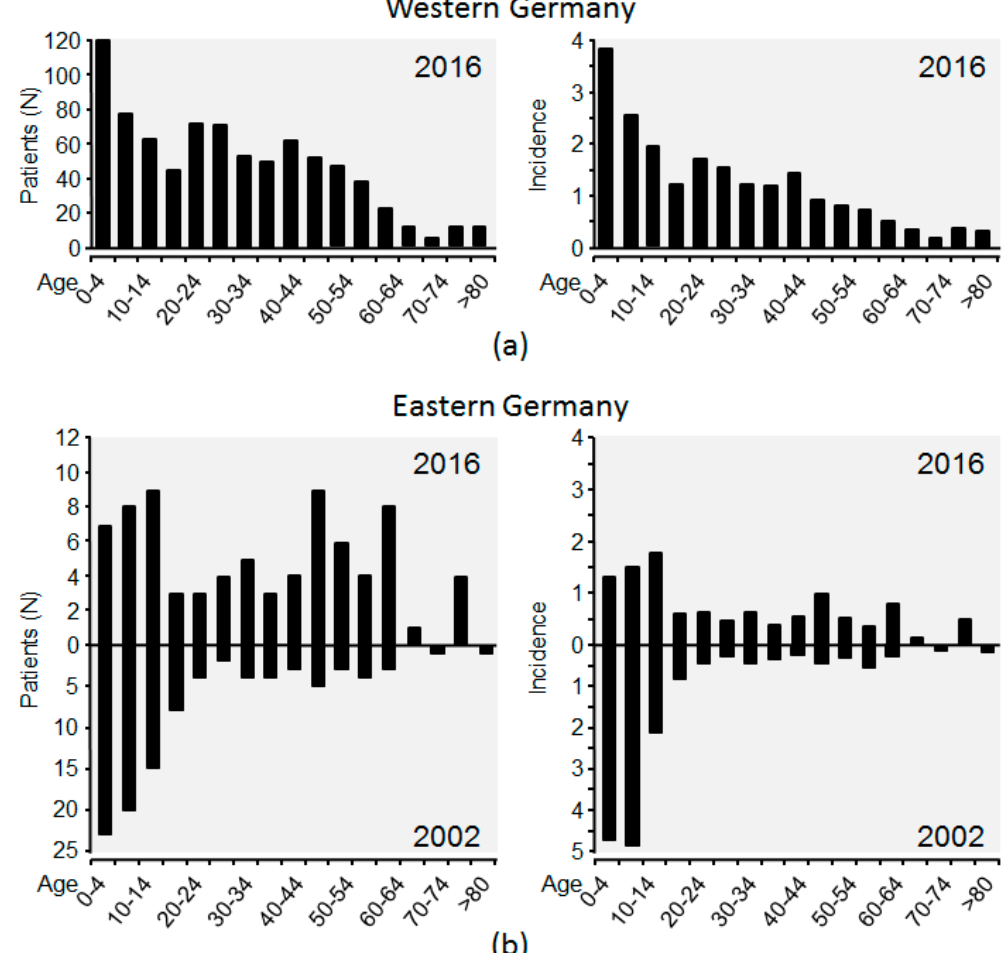
Figure 4. Age of notified patients suffering from mumps in Western and Eastern Germany. Age is given in interval of 5 years. ( a ) Age of affected patients in Western Germany in 2016. ( b ) Age of affected patients in Eastern Germany in 2002 and 2016. Left panels: Number of affected patients per 5-year interval. Rights panels: Mumps incidences (cases/100,000 persons) per 5-years interval. In Western Germany notification of mumps started in 2013 and in Eastern Germany in 2001. Data were obtained from the Survstat tool of the German Robert-Koch-Institute (RKI) [74]. Data were accessed on 12 April 2018. Eastern Germany comprised Brandenburg, Mecklenburg-Western Pomerania, Saxony, Saxony-Anhalt and Thuringia. The other 11 federal states were regarded as Western Germany.